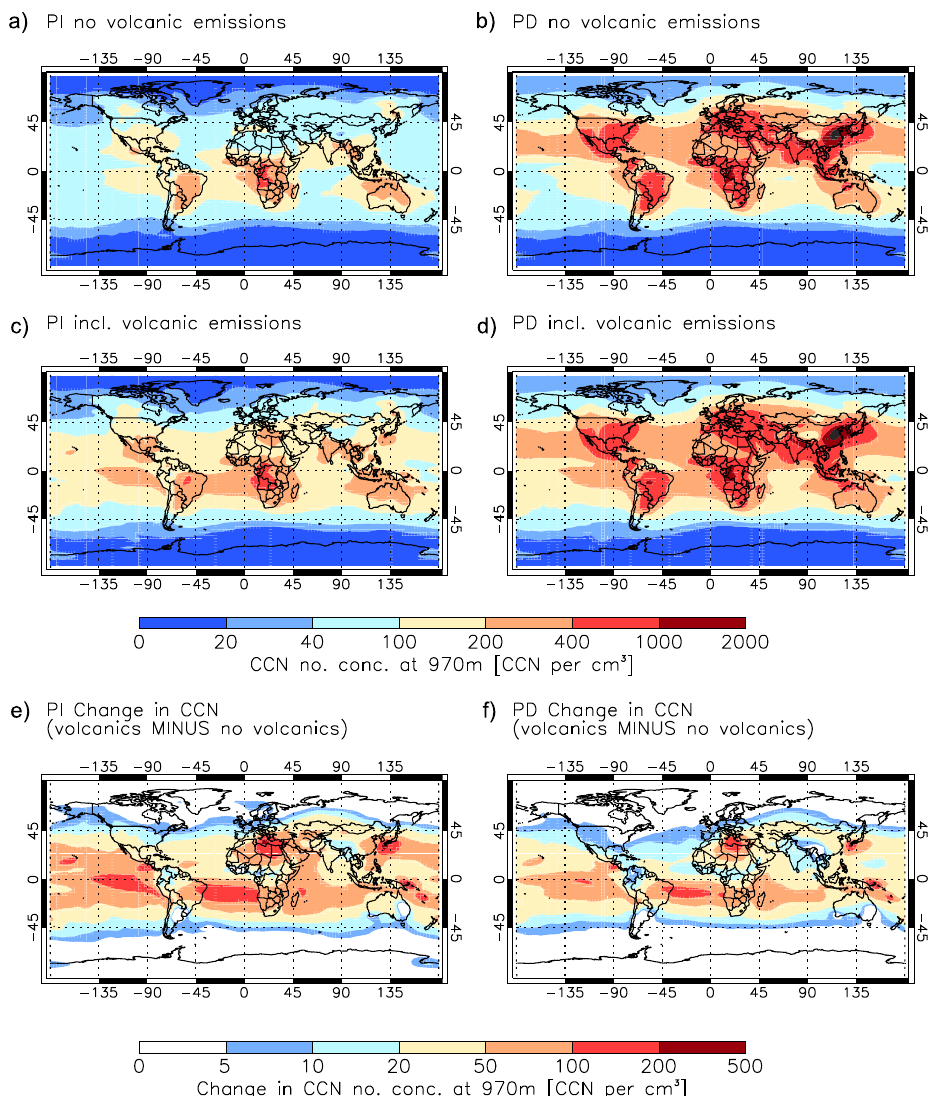
Fig. A1. Annual mean cloud condensation nuclei (CCN) number concentrations (cm − 3 ) at 970m altitude for the pre-industrial (PI) era and present-day (PD) with: (a) PI simulation without volcanic emissions; (b) PD simulation without volcanic emissions; (c) PI simulation using the Andres and Kasgnoc (1998) volcanic emission inventory; and (d) PD simulation with volcanic emissions. The absolute difference in annual mean CCN concentrations for PI and PD are shown in panels (e) and (f) , respectively. Here, CCN is counted as soluble particles with a dry radius larger than 35nm, which is equivalent to the particles that would activate into cloud droplets at 0.22%